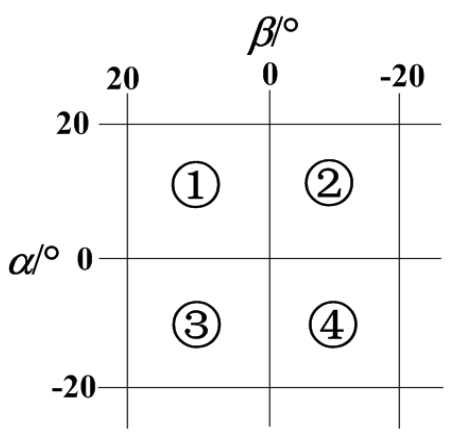
Figure 5. Diagram of measurement interval.